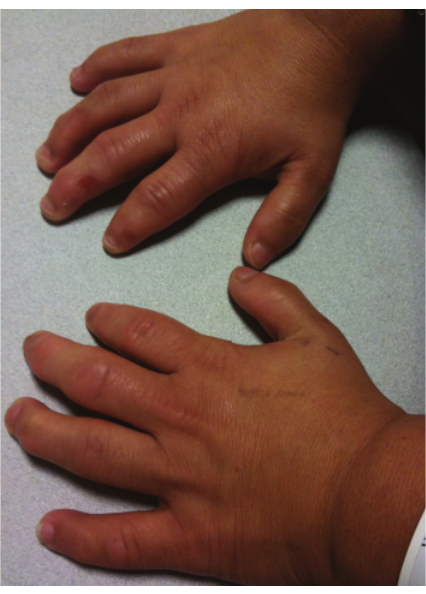
Figure 1: Brachydactyly. The patient had limited joint mobility.